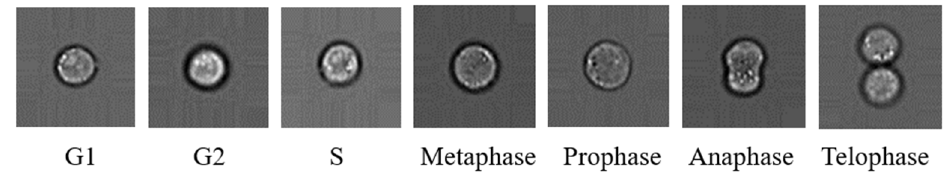
Figure 4. The original images of different cell cycle stages.